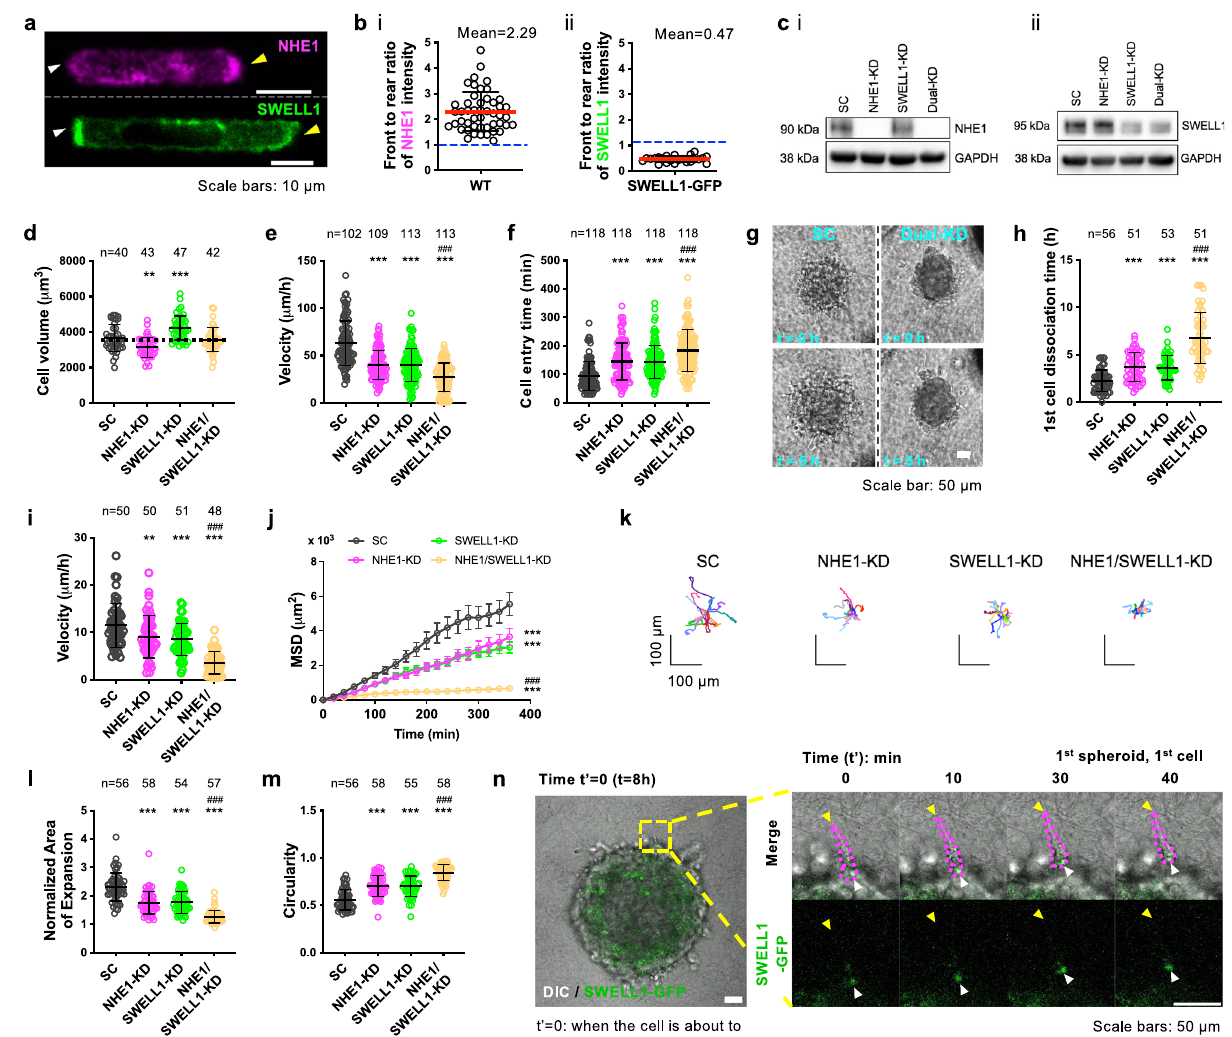
h – k Effects of NHE1 and/or SWELL1 knockdown on h the time for the fi rst cell to dissociate from spheroids, and the i migration velocity, j mean squared displace- ment, and k trajectories of disseminated cells in 3D. Data represent mean±SD for cells analyzed from three independent experiments. l , m Effects of NHE1 and/or SWELL1 knockdown on l normalized area of expansion at t=12h relative to t=0 and m circularity of the spheroids at t=0 embedded in 3D collagen gels. Data represent mean±SD for cells analyzed from three independent experiments. n Time-lapse montage of a SWELL1-GFP-tagged cell (outlined by dashed magenta lines) dissociating from a spheroid embedded in collagen. White arrowheads denote SWELL1 polarization at the cell rear. Yellow arrowheads indicate the cell leading edge. ** p <0.01 and *** p <0.001 relative to SC, ### p <0.001 relative to eitherofsingleKDcells.Testsperformed: d , e , h , i , m one-wayANOVAfollowedby Tukey ’ s post hoc test, f , l Kruskal – Wallis followed by Dunn ’ s, or j two-way ANOVA followed by Tukey ’ s. The number of cells analyzed is indicated in each panel.